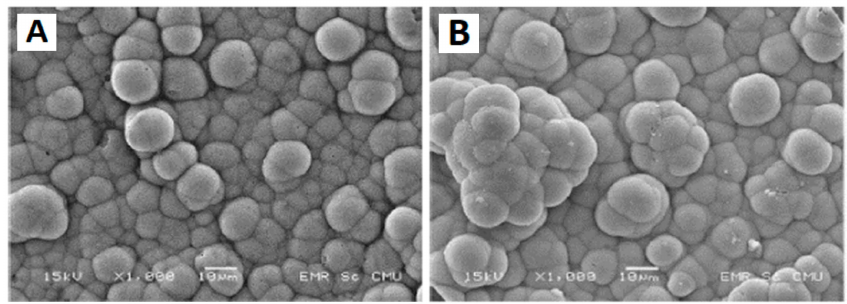
Figure 16. SEM micrographs of the geopolymer surface treated with CaCl 2 solution after soaking in SBF for 3 days ( A ) and 28 days ( B )